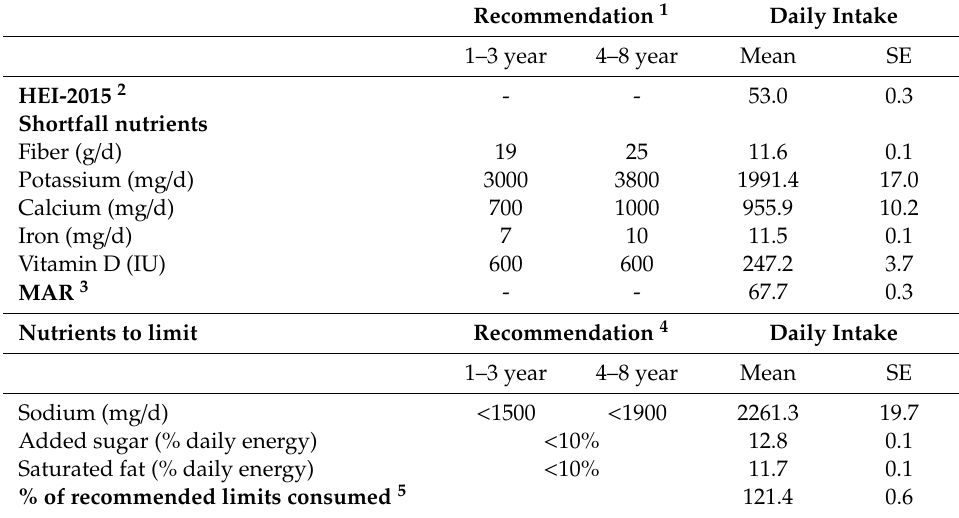
Table 2. Dietary quality and intake of selected nutrients among U.S. children aged two to five years ( n = 4217).